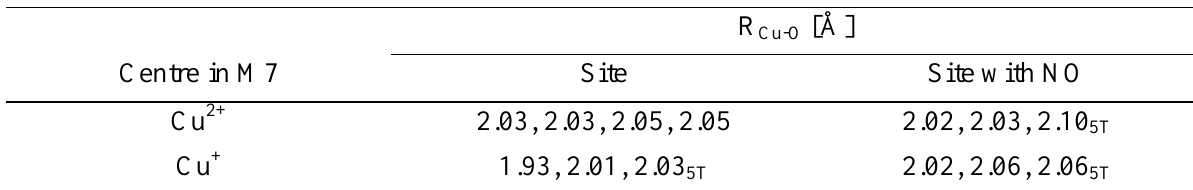
Table 1 . Bond distances between copper cations and bridging oxygens below 2.5 Å, (index oxygen in 5T ring, otherwise in 6T